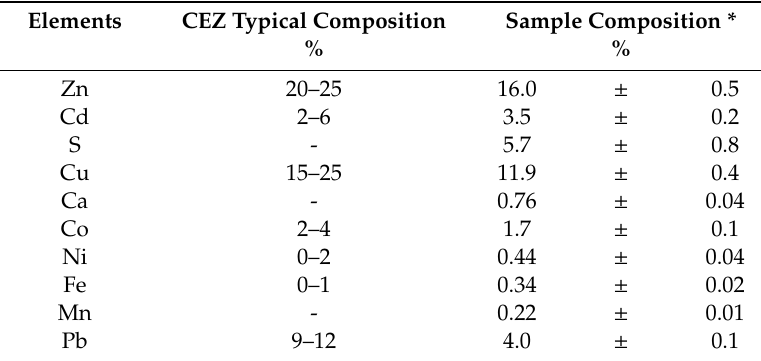
Table 2. Composition of the ZPR.